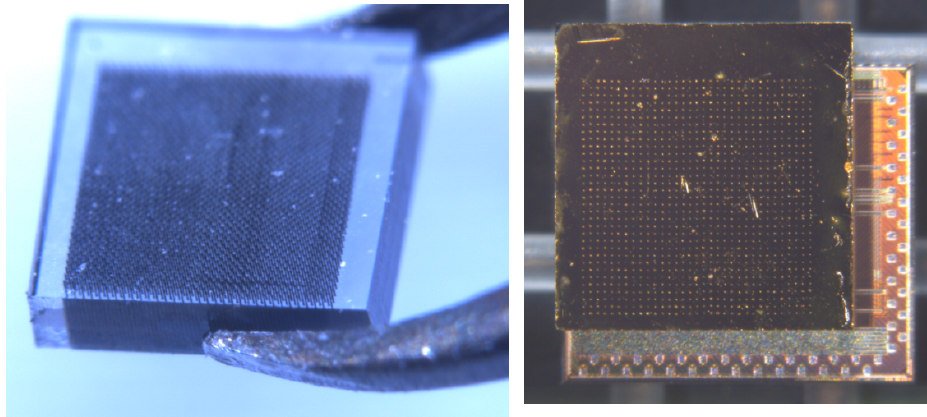
Figure 9. ( Left ): 32 × 32 pixel sensor fabricated on a 2.3 × 2.3 mm 2 scCVD sample. ( Right ): the